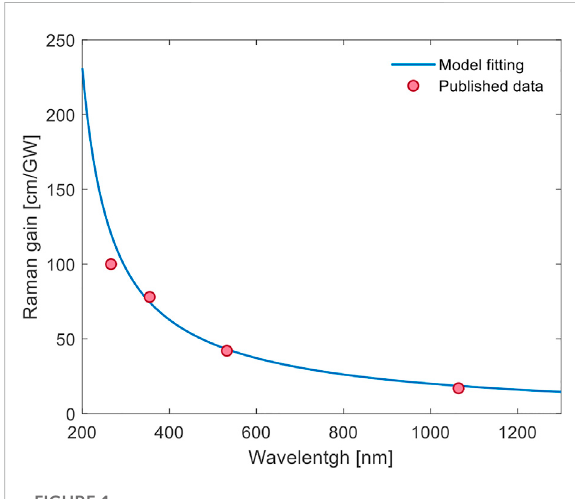
FIGURE 1 Wide-range fi t of a diamond Raman gain model according to [25] (blue) on experimental data (red) from the literature [15,